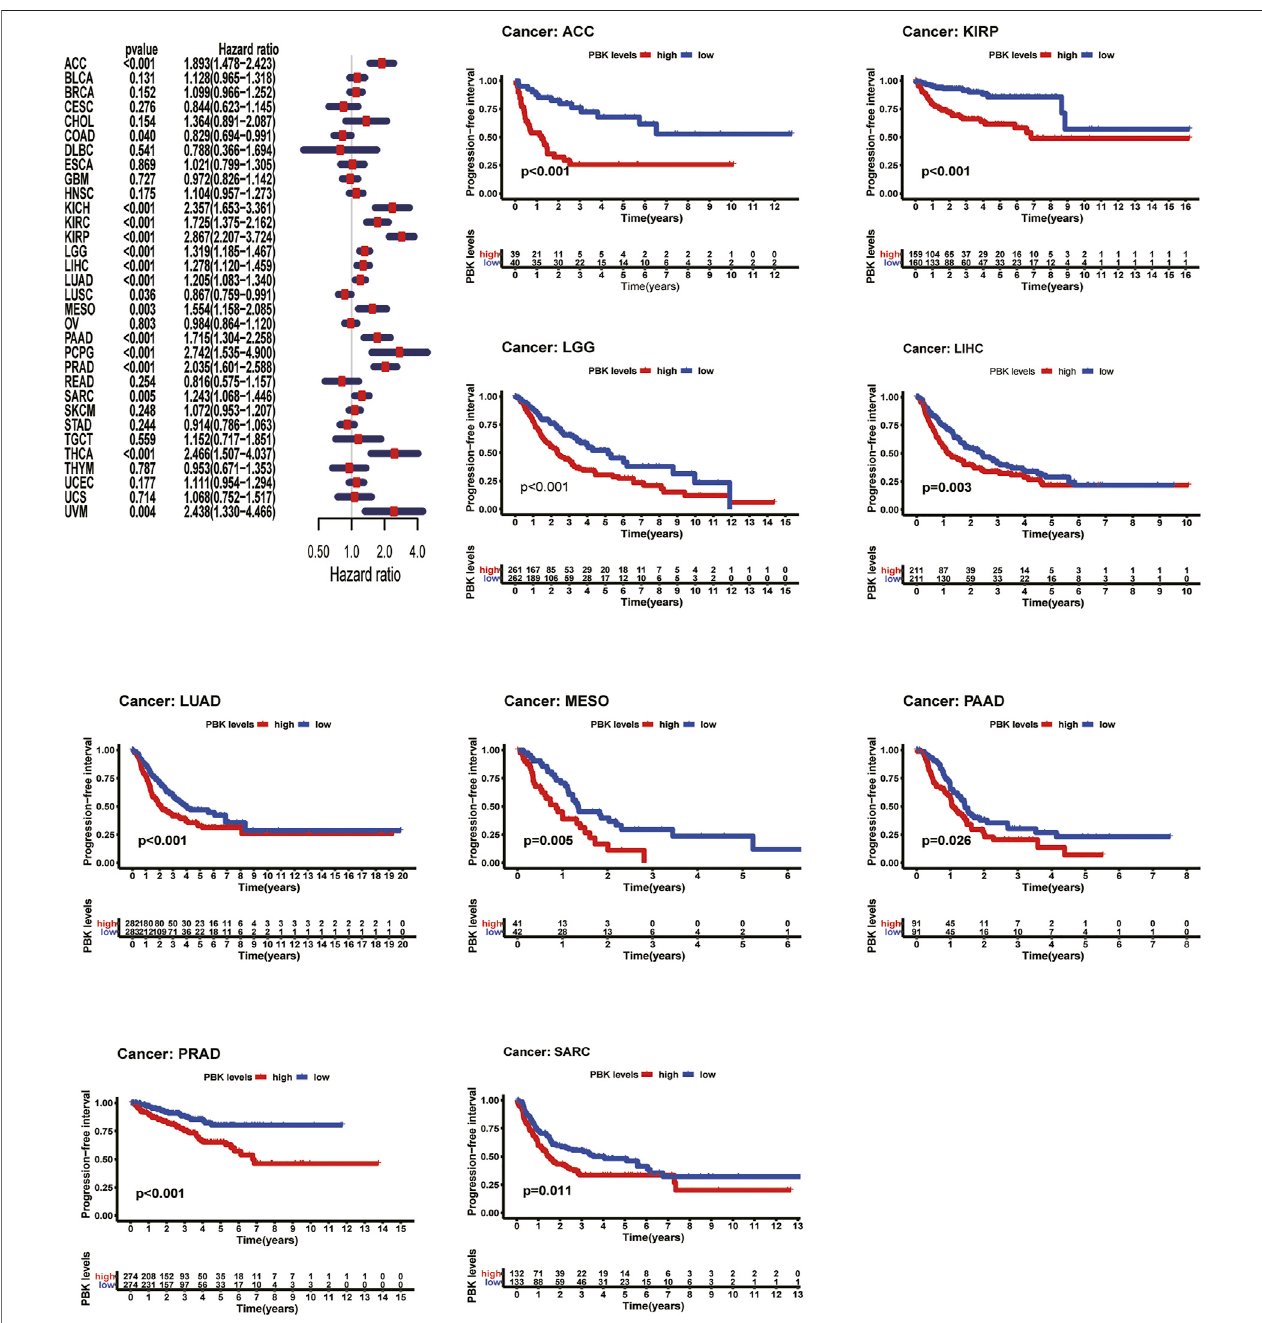
FIGURE 5 | | Relationship of PBK expression with patients ’ DFI. Forest plots of hazard ratios of PBK in 33 cancer types. Kaplan – Meier PFI curves for patients strati fi ed by different expression levels of PBK in fi ve cancer types.